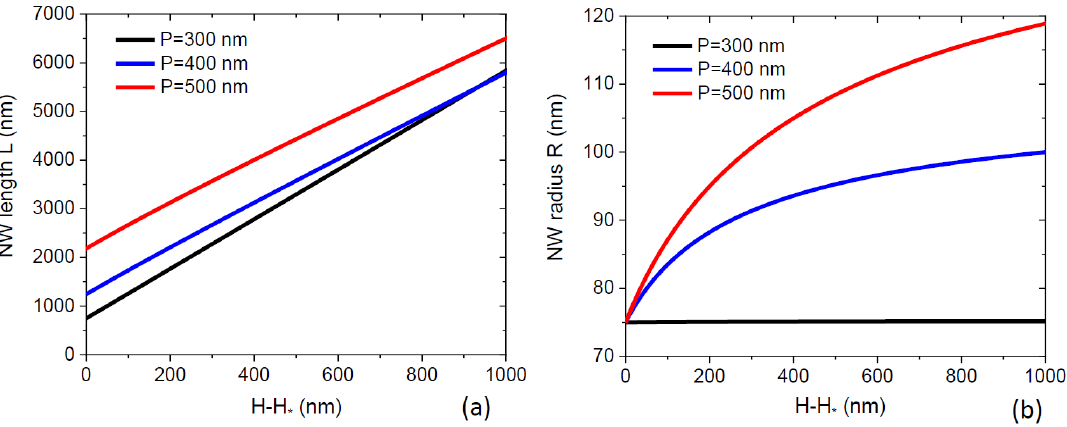
Table 2. Parameters used in Figure 5.